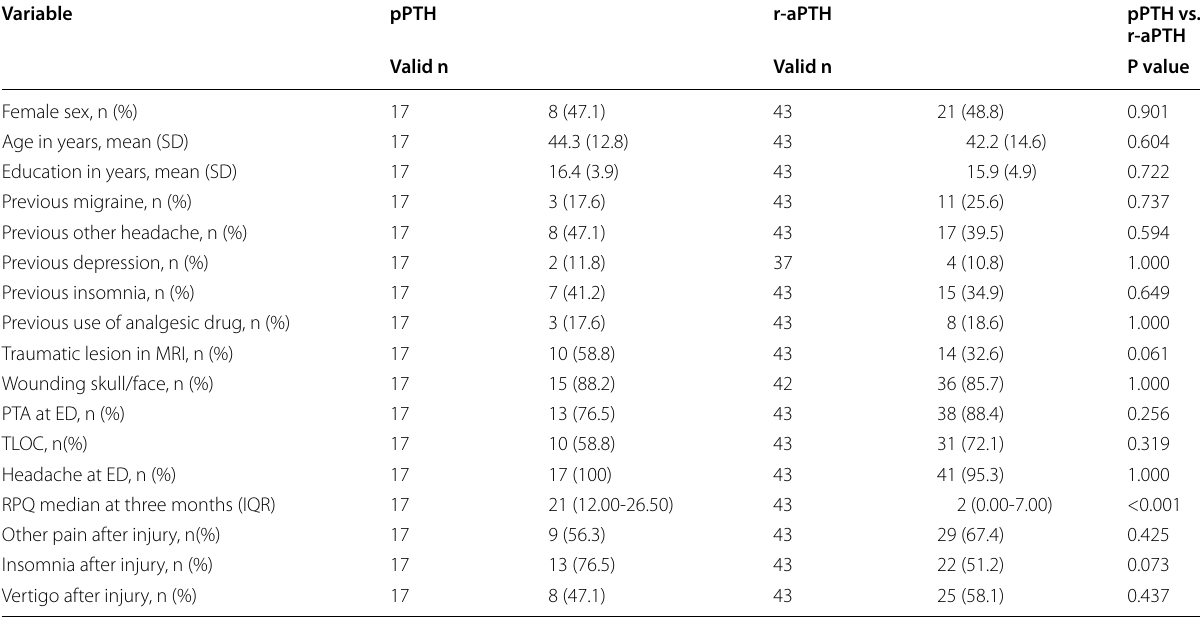
Table 3 Patient demographics and characteristics in patients with persistent and recovered-acute post-traumatic headache three months after injury